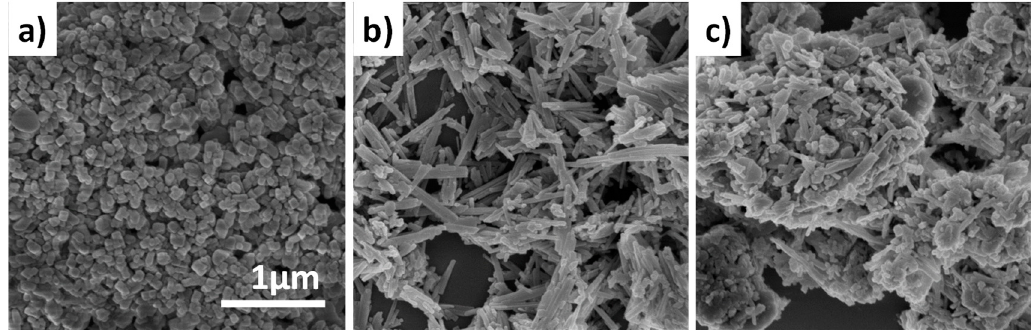
Figure 4. Scanning electron microscopy (SEM) images of H-ZSM-5 ( a ), attapulgite ( b ) and calcined HZ-atp extrudate ( c ). The scale bar represents 1 μ m and applies to all images. To measure the textural properties of the pure H-ZSM-5 zeolite, the pure binders and the zeolite extrudates (HZ-atp and HZ-bo), N 2 physical adsorption at − 196 °C was employed. As shown in